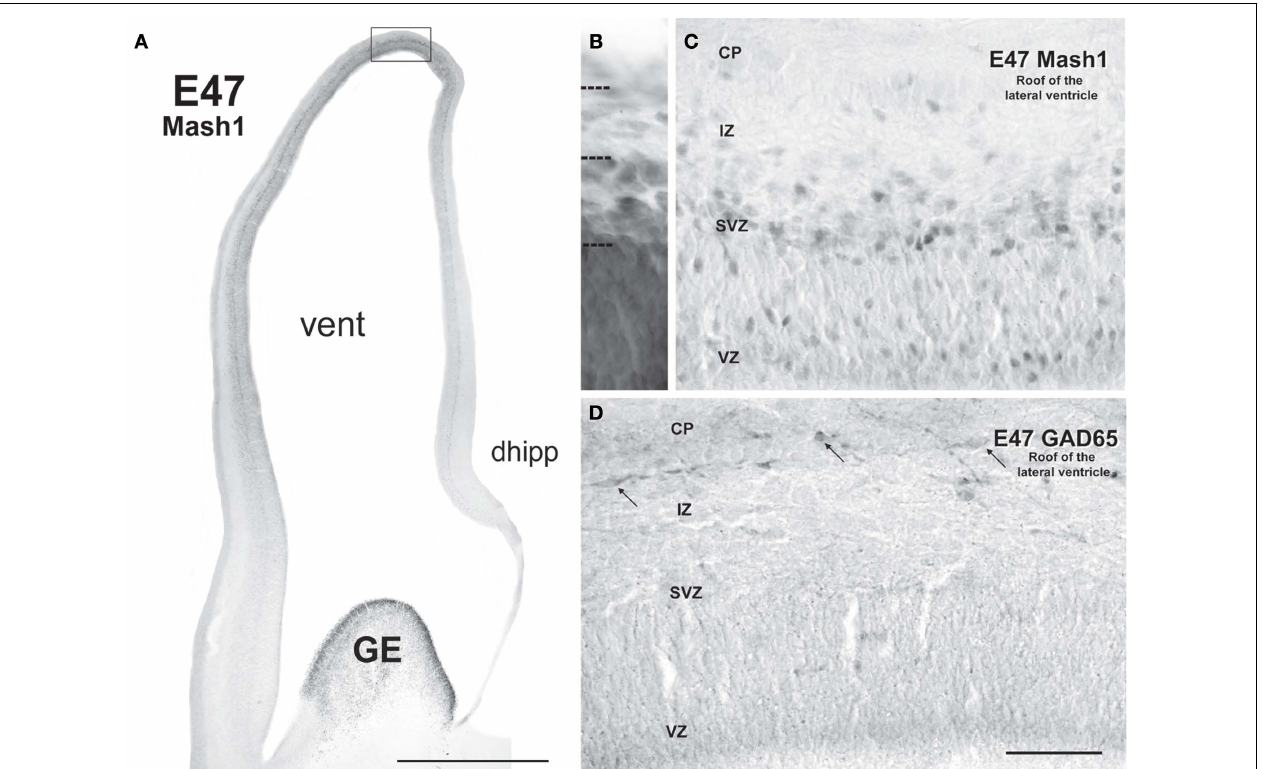
FIGURE 5 | Mash1 and GAD65 labeling patterns in coronal sections of monkey fetal telencephalon at embryonic day (E) 47 suggest that neurogenesis of GABAergic neurons is induced locally. (A) At E47 Mash1 was highly expressed in the proliferative zone of the ventral telencephalon, the ganglionic eminence (GE). Mash1 immunoreactivity was also observed in the proliferative zones of the dorsal telencephalon. It followed a clear dorso-ventral decreasing gradient in the labeling intensity within the entire cortical wall. Moderate level of labeling was observed in the most dorsal part of the telencephalon [indicated by square and magnifi ed in panel (C) ]. The intensity of staining decreased in the lateral and medial wall. No Mash1 immunolabeling was observed close to the GE, nor in the most ventral part of the medial telencephalic wall, that corresponds at this level to dorsal hippocampus (dhipp). (B) Cresyl violet